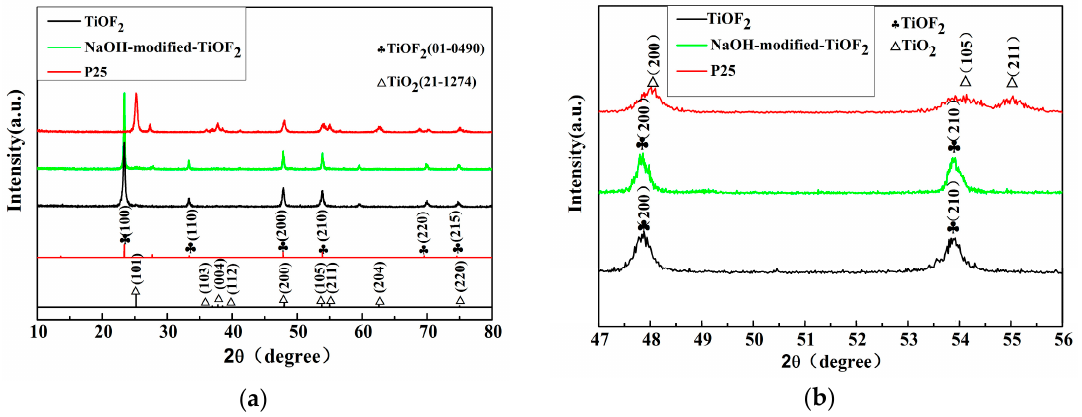
Figure 1. XRD pattern with 2 θ from 10° to 80° ( a ) and partial enlarged detail of 2 θ from 47° to 56° ( b ) of as-prepared TiOF 2 , NaOH-modified TiOF 2 , commercial P25 and a standard card of TiOF 2 and TiO 2 . The normal distances of TiOF 2 are 7.26, 17.81, 11.67, 10.77, 17.38, and 16.98 nm along the (100), (110), (200), (210), (220), and (215) planes [7,13], respectively, while the distanced of